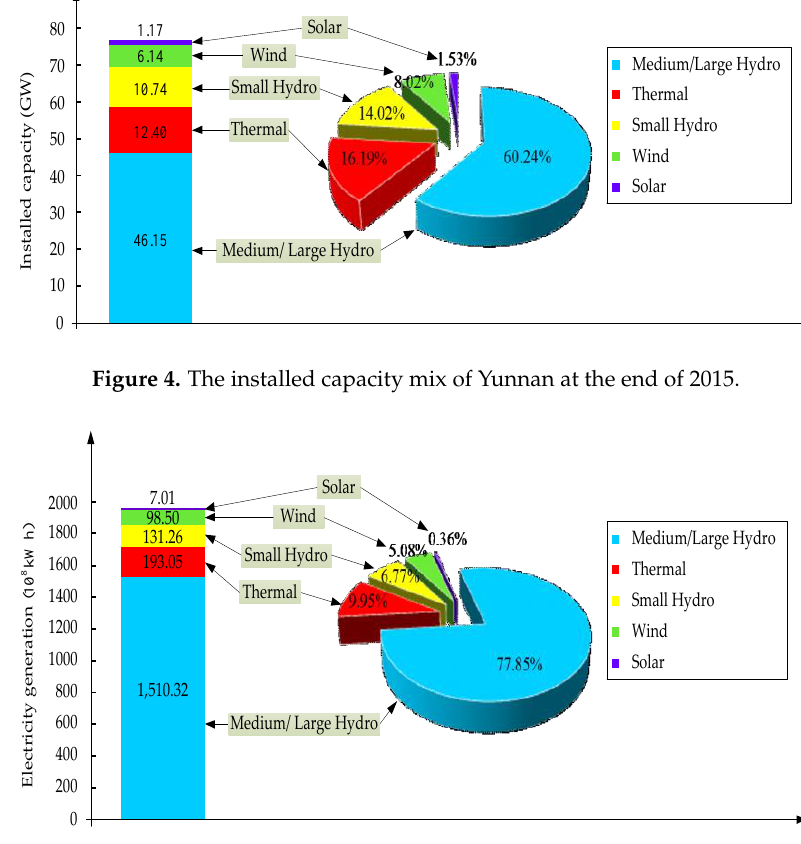
Figure 5. The electricity generation mix of Yunnan at the end of 2015.